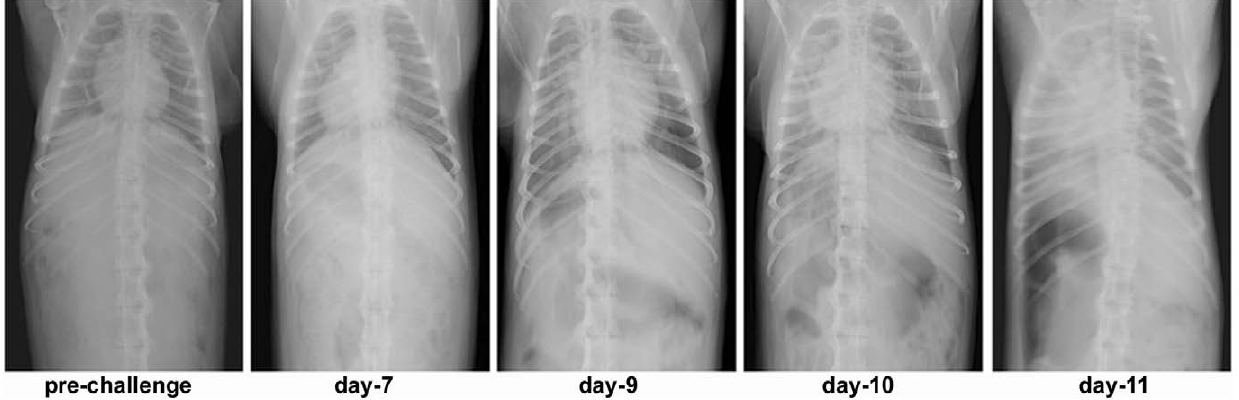
Figure 5. Progressive NiV pathogenesis in the African green monkey analyzed by X-ray autoradiography. Subject 3 that succumbed on day 11 after i.t. and oral exposure to 8.1 6 10 4 pfu of NiV. X-ray images of chest, days 3 to 11 showing progressive lung pathology. Day 7, evidence of developing pneumonia or congestion. At day 10 and 11 congestion and pneumonia with infiltrates on the lung fields. These are the first X-ray images of severe lung pathology induced by a BSL-4 restricted viral pathogen.